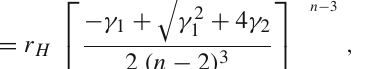
Fig. 6 a Hereweplottheboundonthegreybodyfactorforascalarfield in Bulk with respect to varying spacetime dimensionality n for r H = 1, different values of l and a conveniently chosen frequency ω = 8. b Here we plot the bound on the greybody factor for a scalar field in 3- Brane with respect to varying spacetime dimensionality n for r H = 1, different values of l and a conveniently chosen frequency ω = 8. Both √ ω 2 − V of the plots correspond to the second case h =